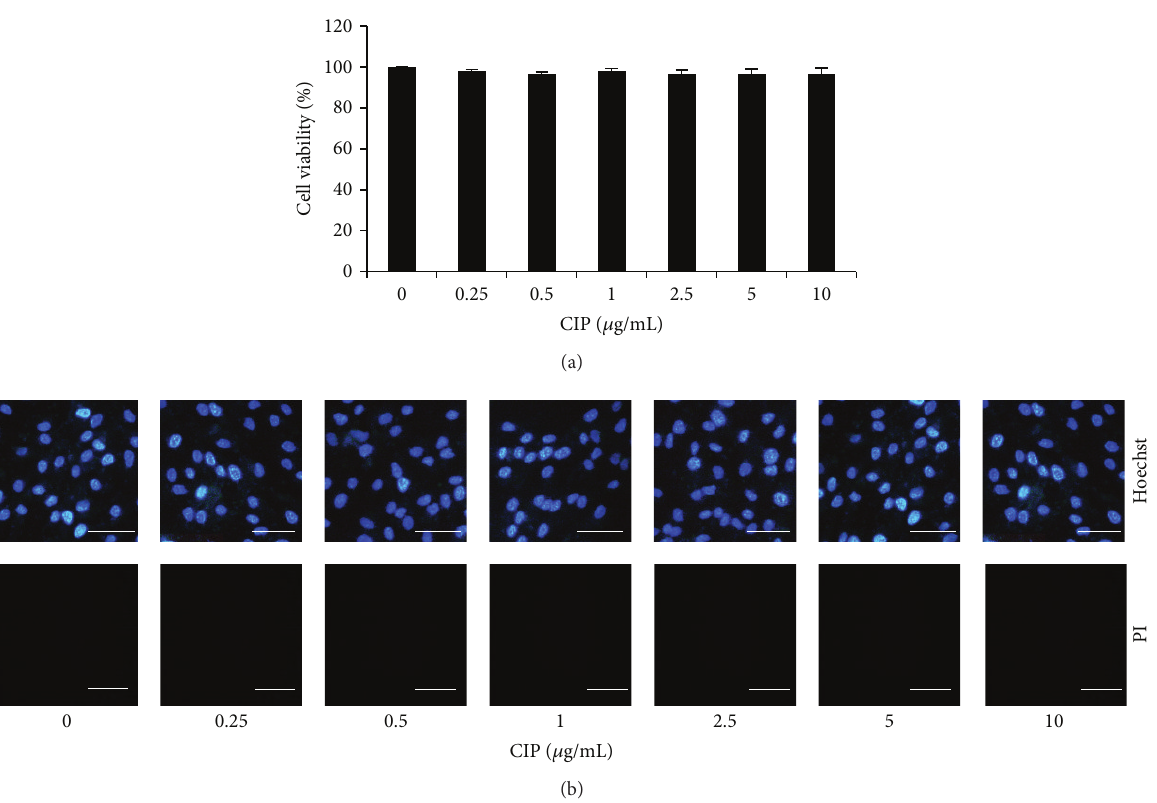
Figure 1: Cytotoxicity of CIP on DPCs. (a) Cells were treated with CIP (0–10 𝜇 g/mL) for 24 h. Cytotoxicity was determined by MTT assay. (b) After indicated treatment for 24 h, mode of cell death was examined by Hoechst 33342/PI costaining assay. Scale bar is 100 𝜇 m. The data represent the means of four independent samples ±